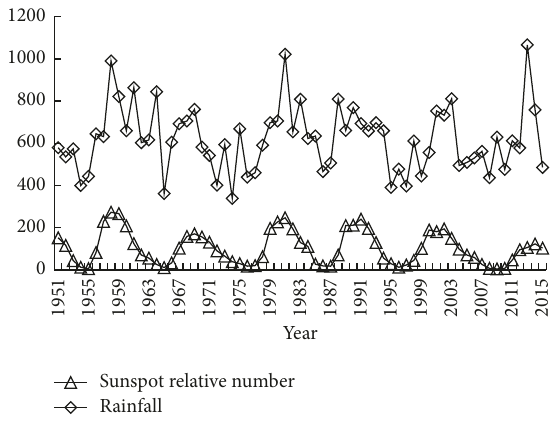
Figure 2: Variation in precipitation in the Yan’an area and sunspot